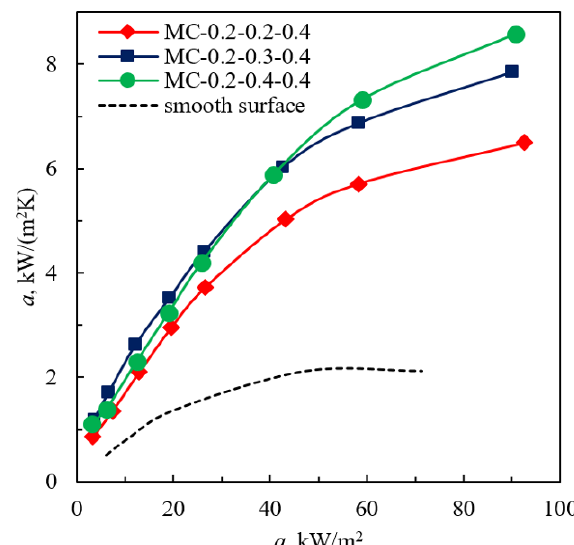
Fig. 4. Boiling curves for Novec-649, heat transfer coefficient vs. heat flux.